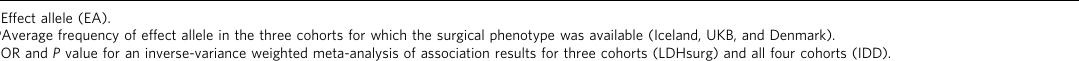
a Effect allele (EA). b Average frequency of effect allele in the three cohorts for which the surgical phenotype was available (Iceland, UKB, and Denmark). c OR and P value for an inverse-variance weighted meta-analysis of association results for three cohorts (LDHsurg) and all four cohorts